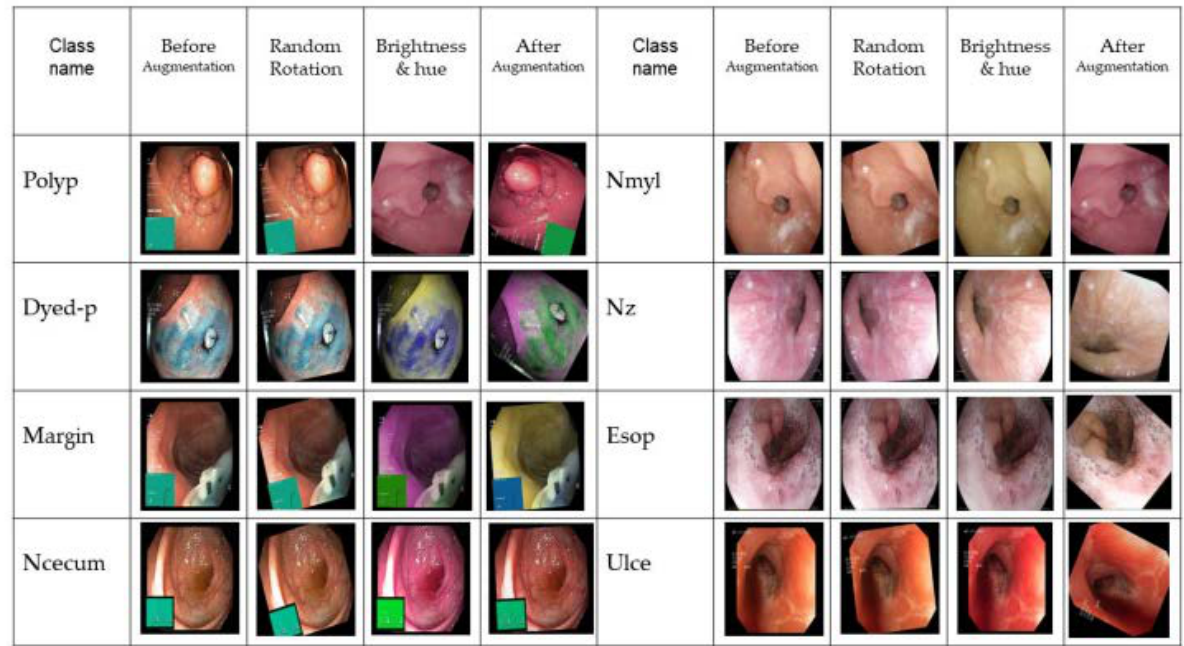
Figure 3 . Data augmentation methods and the result of augmentation . Figure 3. Data augmentation methods and the result of